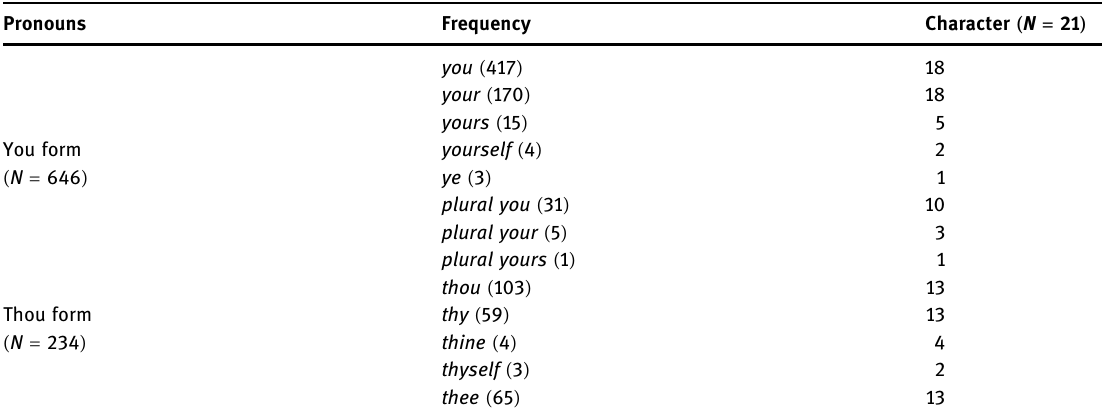
Table 2: Frequencies of all you and thou